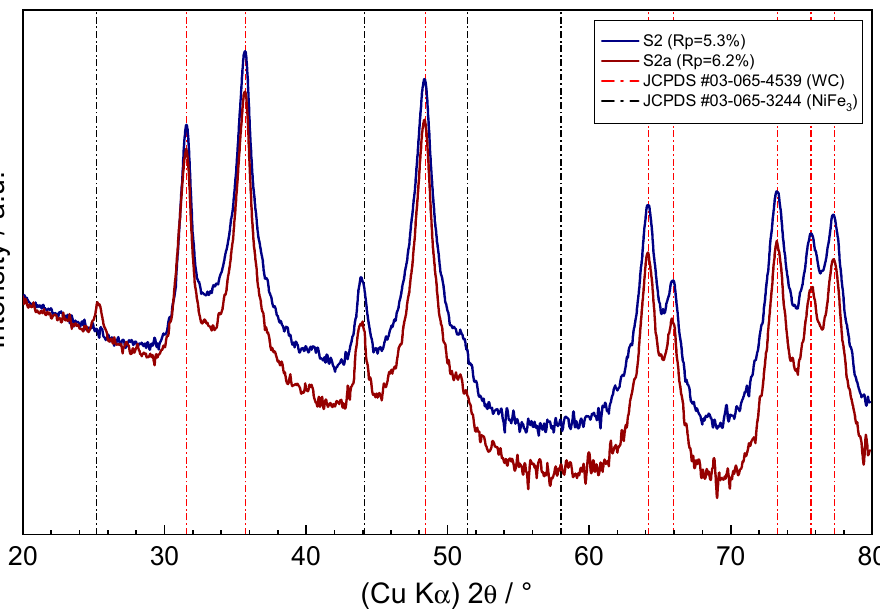
Figure 5. Grazing incidence XRD pattern of the WC–9FeNiCo–1Cr 3 C 2 –0.5NbC sample before (S2) and after the corrosion process (S2a). Table 4. The results of electrochemical DC techniques.